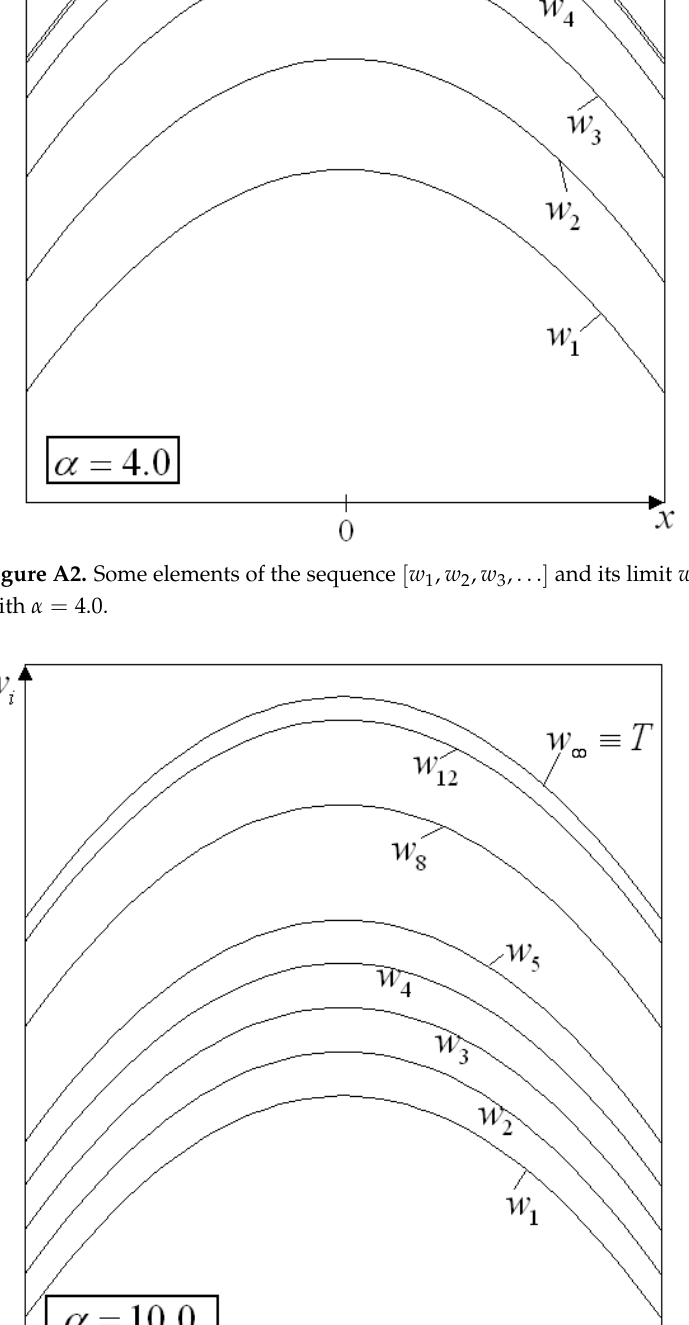
Figure A3. Some elements of the sequence [ w 1 , w 2 , w 3 , . . . ] and its limit w ∞ (exact solution), obtained with α =